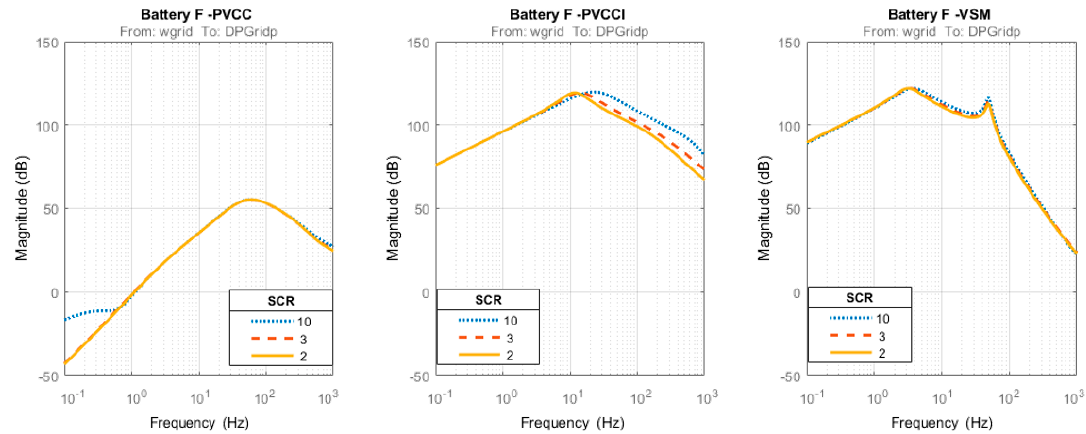
Figure 14. Frequency responses for the battery ‐ connected controllers for different SCRs.